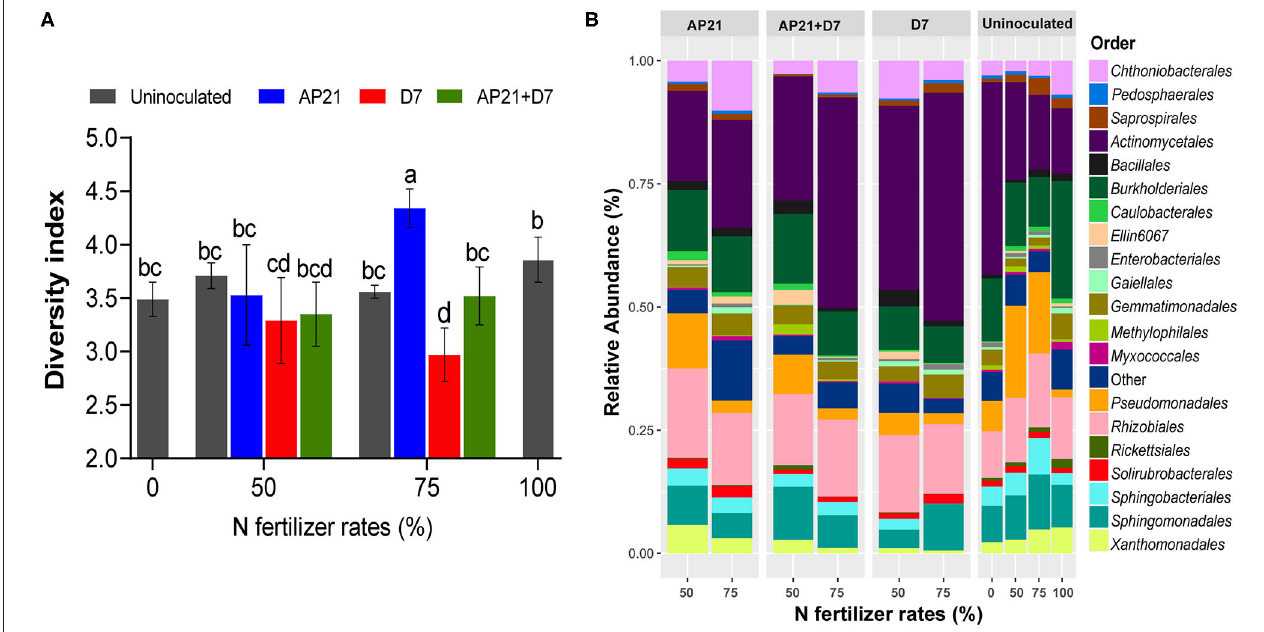
FIGURE 3 | Variations in the Shannon-Weiner diversity index (A) and relative abundance of bacterial orders (B) in the rhizosphere for inoculation with Herbaspirillum sp. AP21, Azospirillum brasilense D7, and co-inoculation with Herbaspirillum sp. AP21 + Azospirillum brasilense D7 under different rates of nitrogen fertilization. Different letters indicate significant differences based on Duncan’s test ( p < 0.05). Each value is the mean of three replicates per treatment.